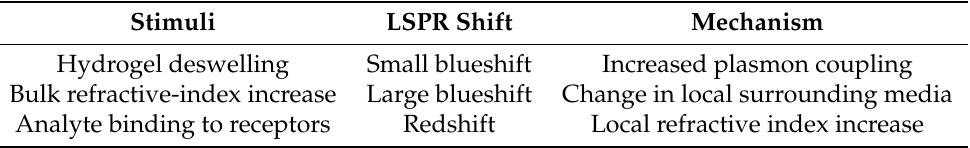
Table 2. Summary of results for LSPR sensor in the λ II